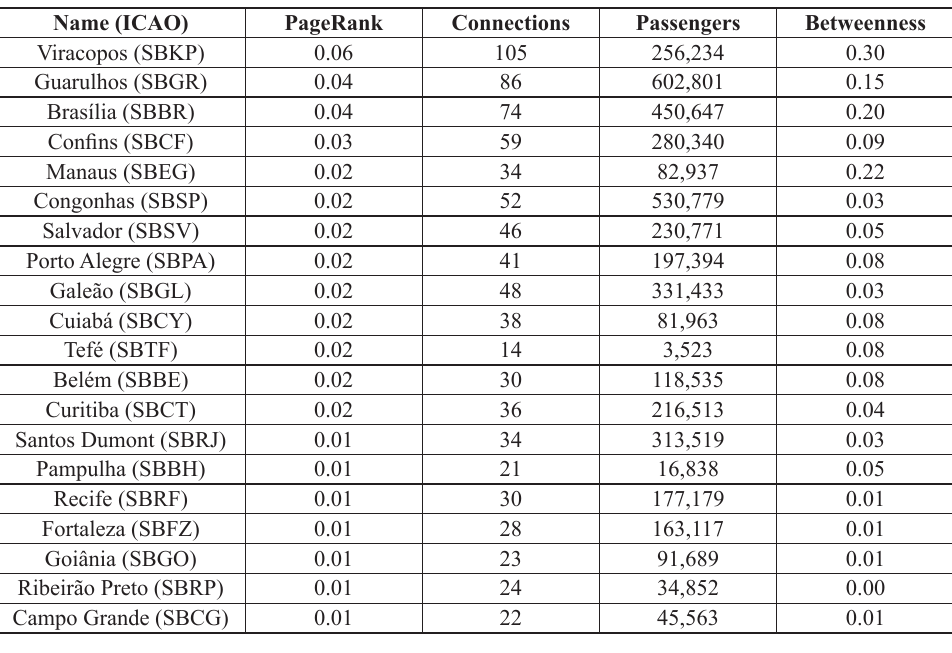
Top-20 Airports - PageRank Centrality - National Flights.